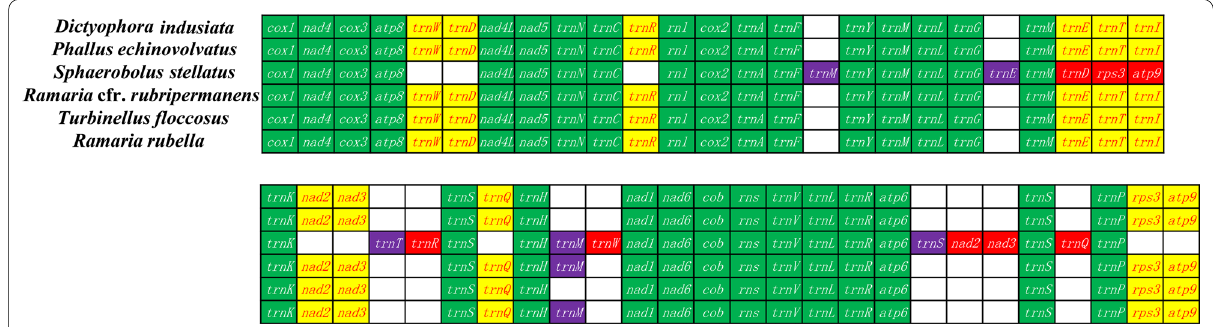
Fig. 8 Mitochondrial gene arrangement analyses of the 6 Phallomycetidae species. Genes in the green color block indicate that genes from all the six species have identical arrangements; genes in the yellow color block indicate that genes from five of the six species have identical arrangements; genes in the red color block indicate that the gene has been transferred; and genes in the purple color block indicate that the gene has